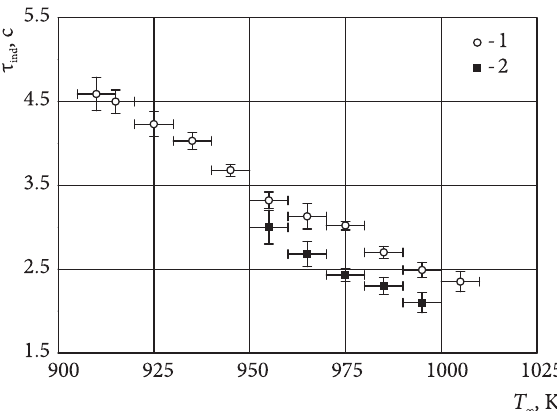
Fig. 4. Single droplet ignition delay time reliance on ambient temperature: 1 – diesel fuel (MD), 2 – two-component fuel